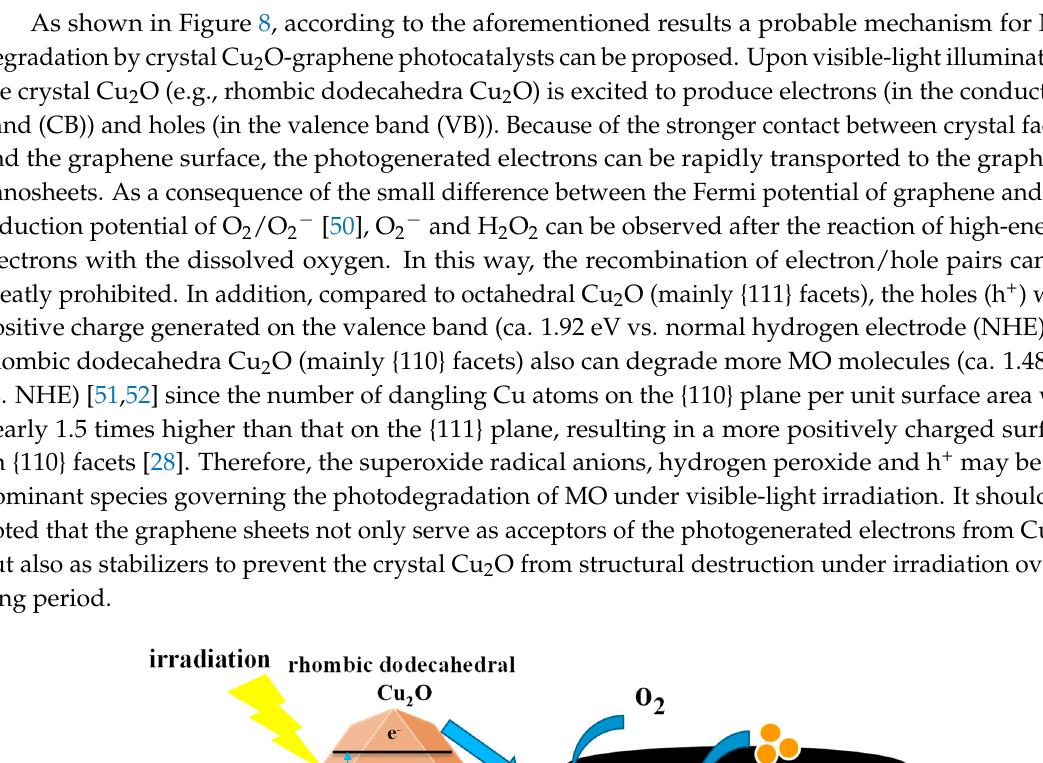
2 O-G under visible-light